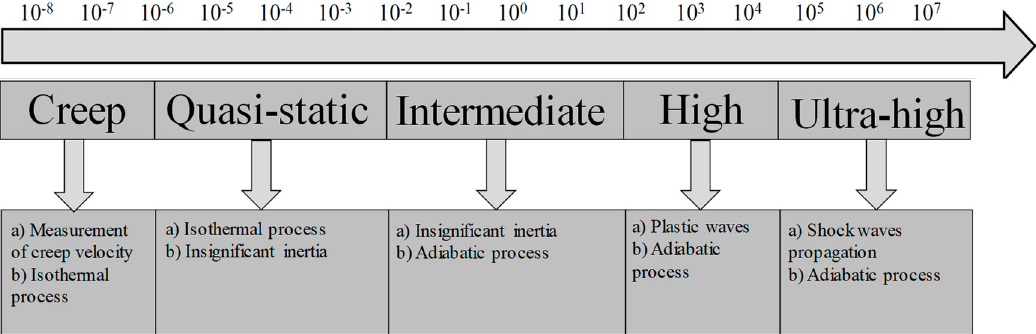
Figure 1. Regimes of strain rate.